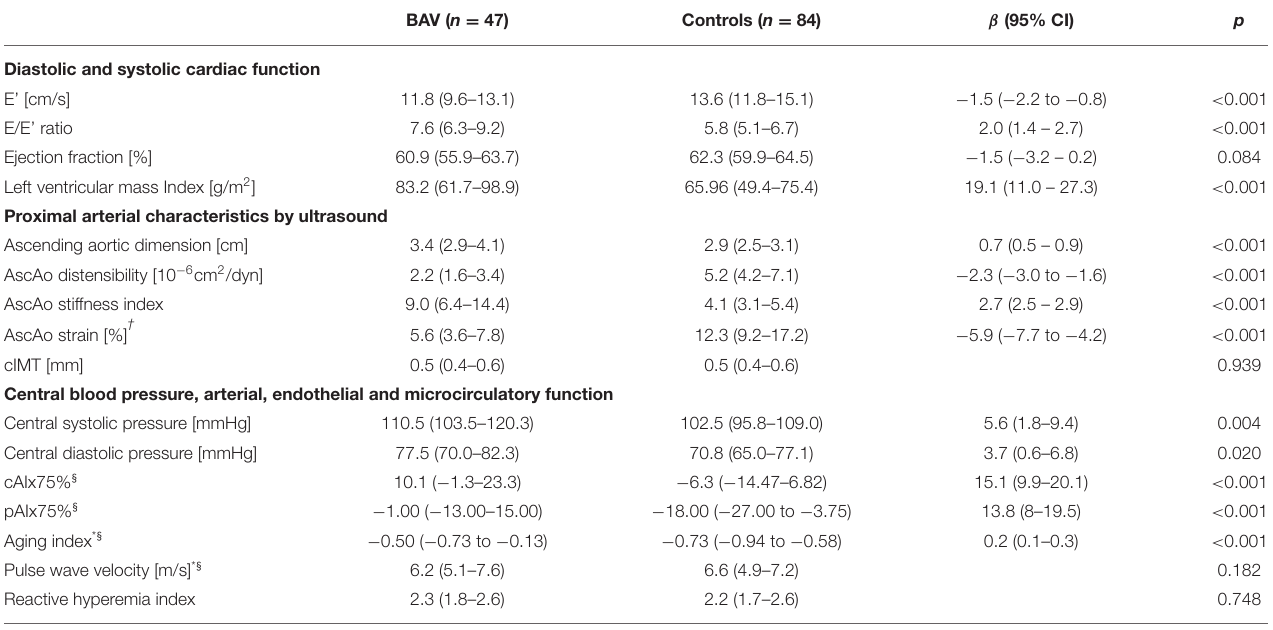
TABLE 2 | Descriptive statistics and linear regression model comparing outcome variables of BAV patients to